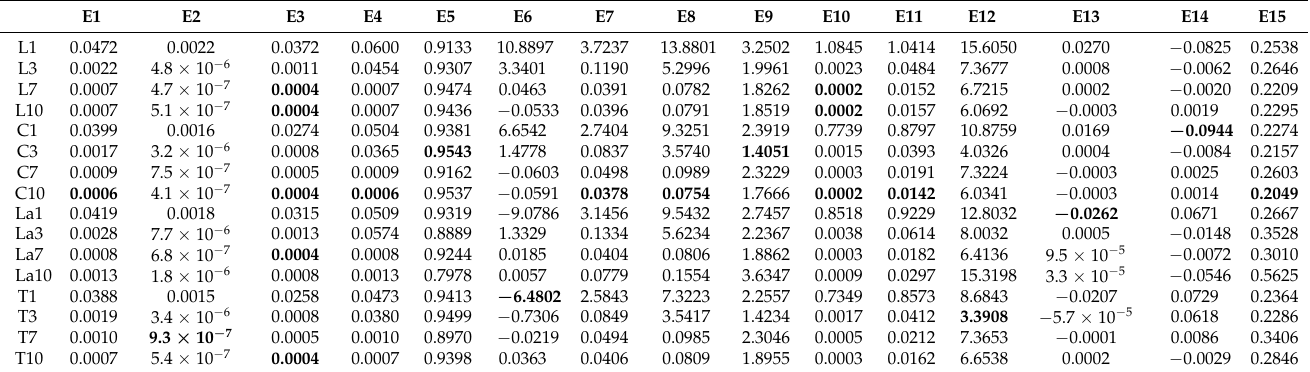
Table 15. Error values in testing 16 predictor models for Coinbase Pro dataset.